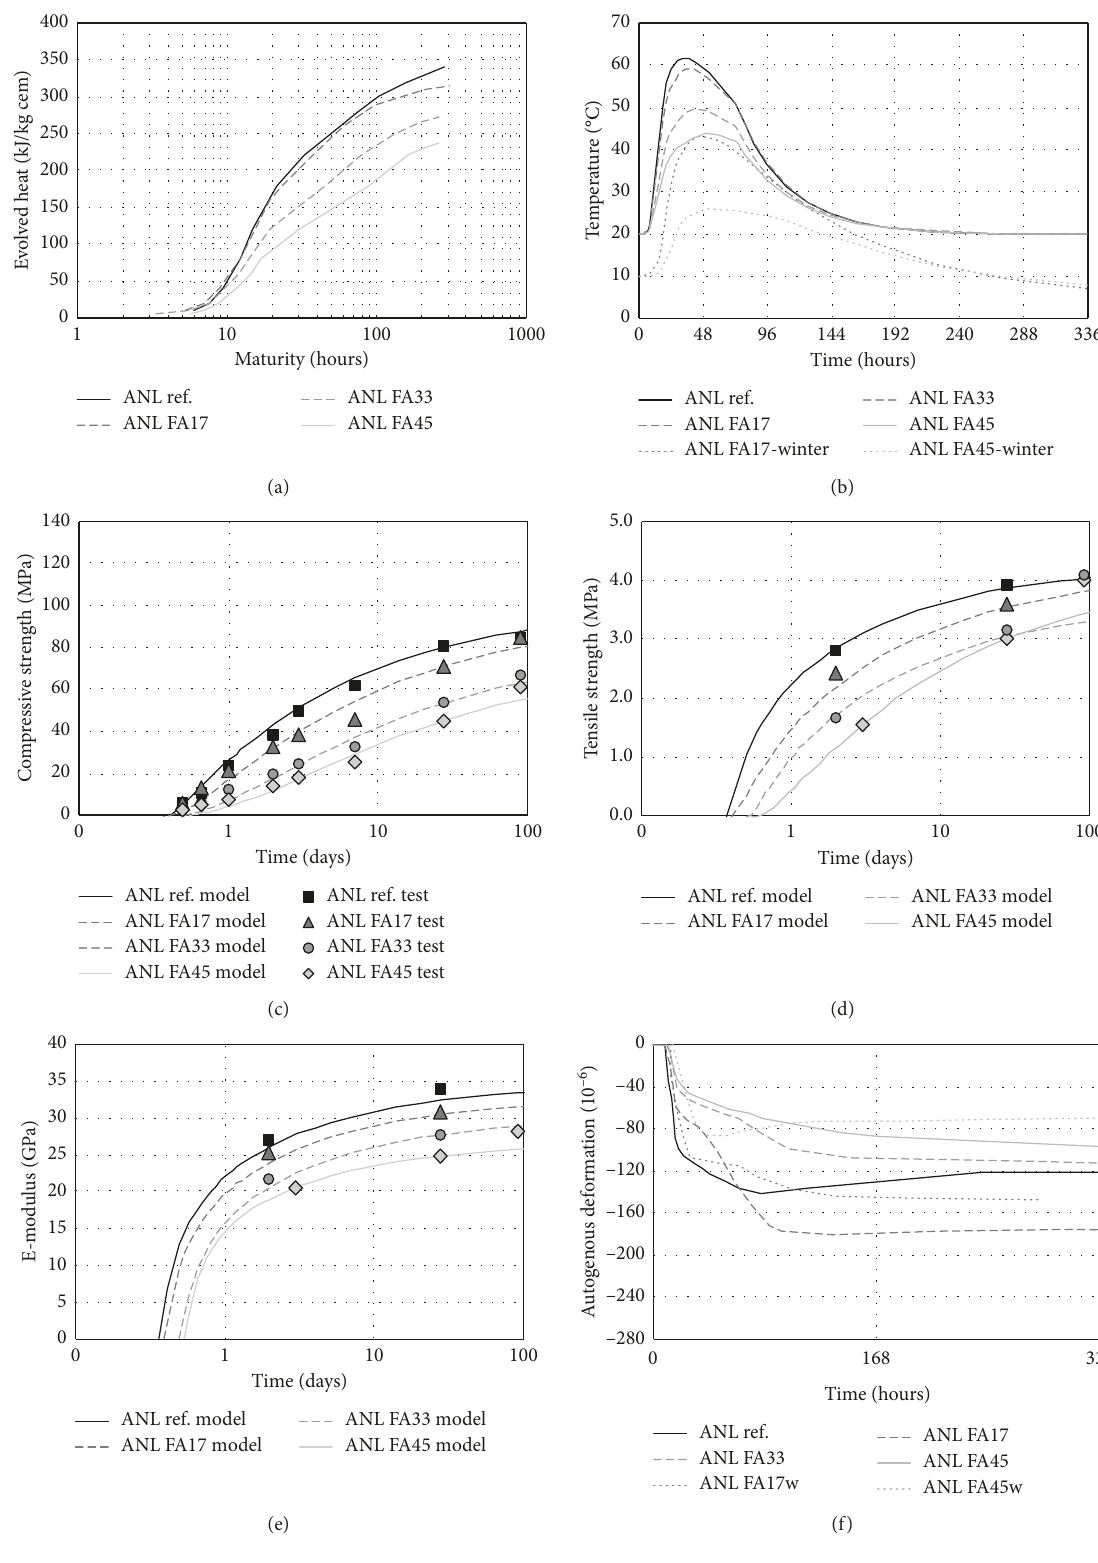
Figure 4: Heat and property